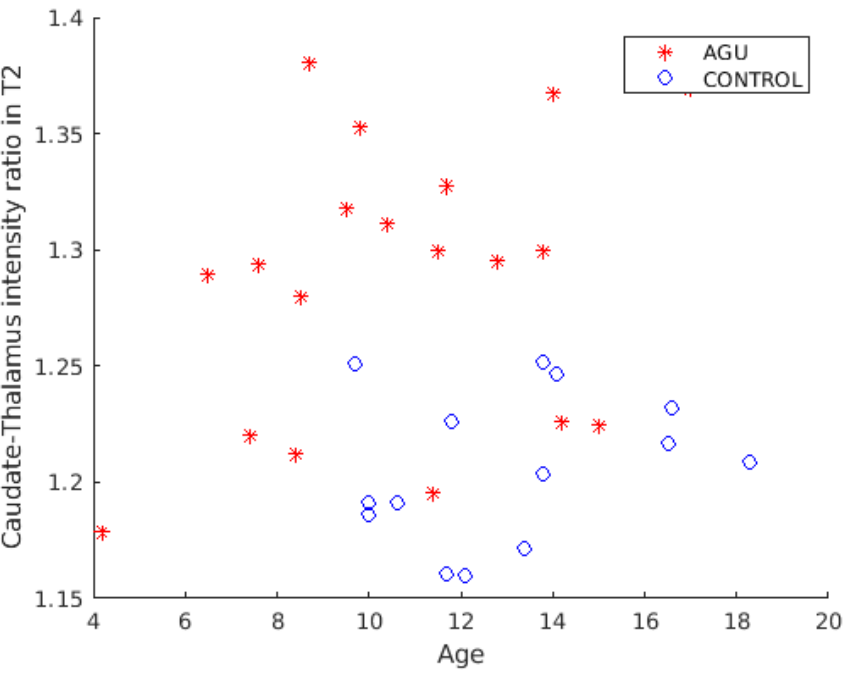
Figure 3. T2-weighted caudate-thalamus intensity ratio plotted against the age in years. The y -axis shows the caudate-thalamus intensity ratio in the T2-weighted images, whereas the x -axis depicts the age in